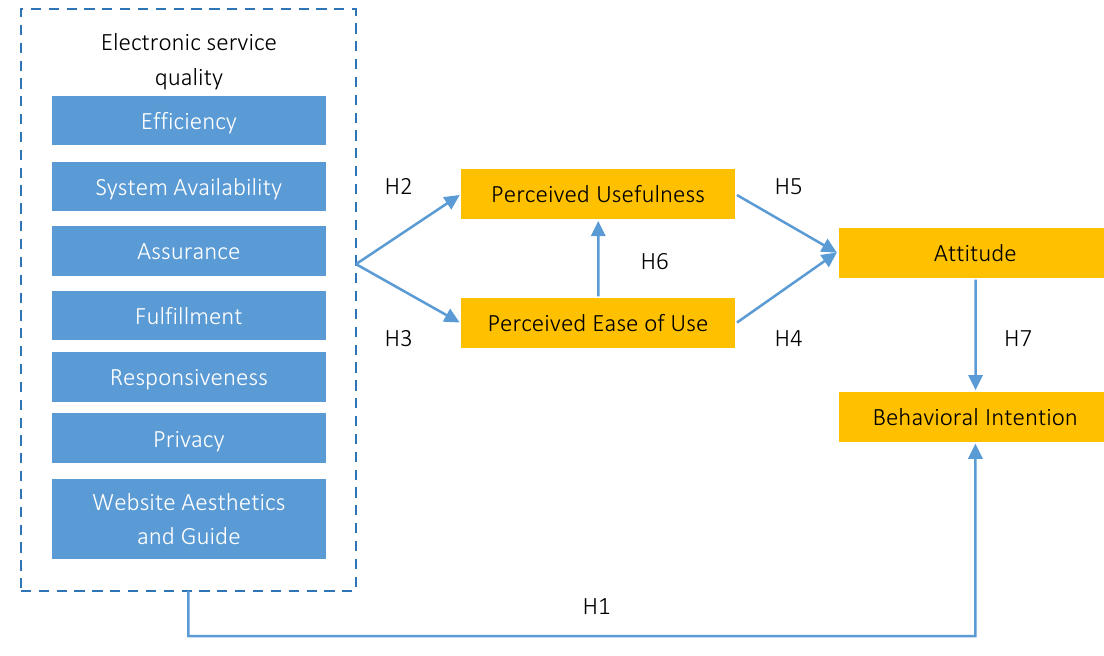
Figure 2. Proposed research